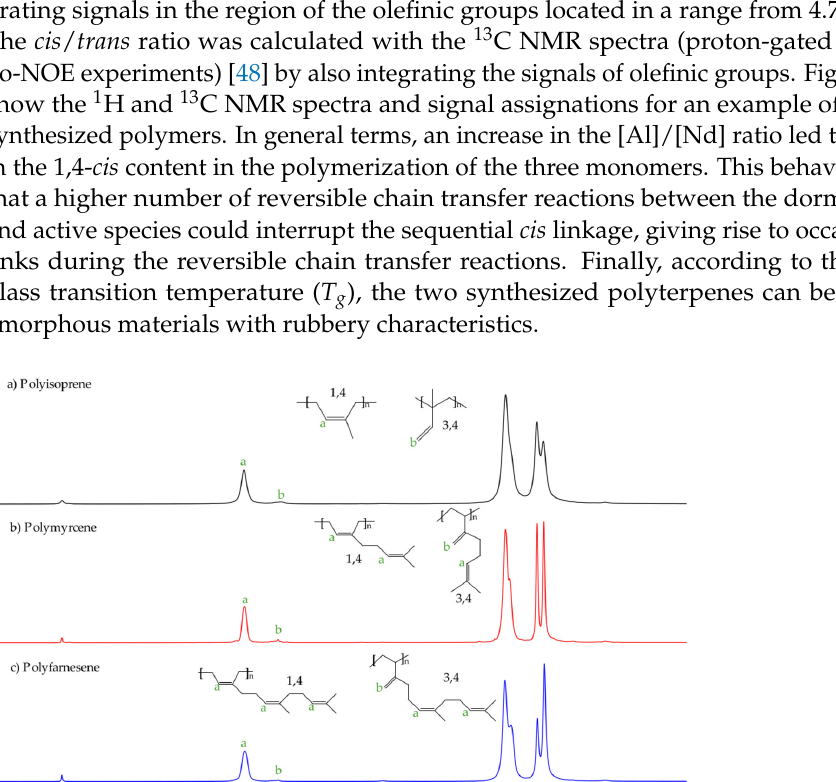
Figure 3. 1 H NMR spectra using CDCl 3 as solvent on ( a ) Ip: entry Ip-11, ( b ) My: entry My-11, and ( c ) Fa: entry Fa-15.